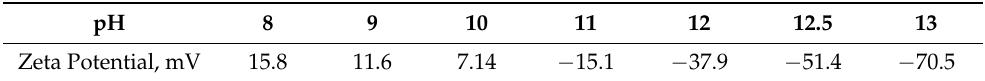
Table 1. The zeta potential of Ag-NPs, based on the pH value.